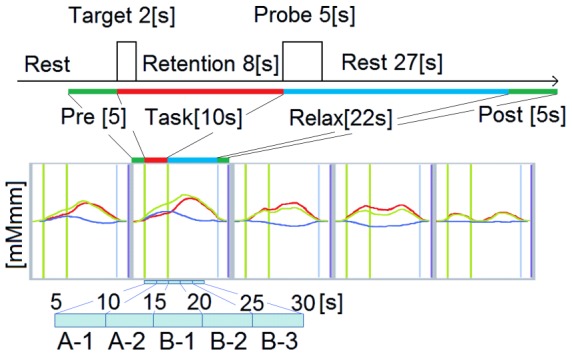
Diagram of the task and the corresponding NIRS time distribution.Data were analyzed using the “integral mode” to obtain the average of the pre-task baseline and the post-task baseline (top row, green line). Linear fitting was applied to the data between these two baselines. The moving average method was used to exclude short-term motion artifacts. The oxy-Hb data from each channel were averaged across the initial 25 s of the activation period (task + first 15 s of relax), which was divided into five time segments of 5 s each (A-1: earlier phase of maintenance, A-2: latter phase of maintenance, B-1: first phase of reaction, B-2: second phase of reaction, and B-3: third phase of reaction).